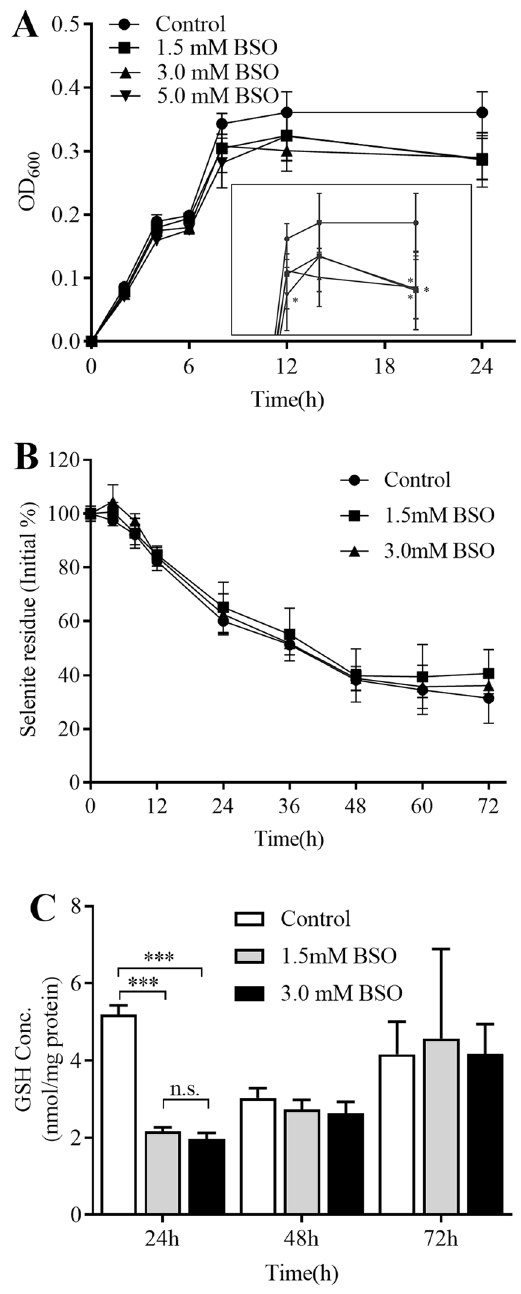
Figure 5. Effect of BSO on the growth and selenite reduction in E. cloacae Z0206 . ( A ) Growth of E. cloacae Z0206 in the presence of 1.5 mM, 3.0 mM and 5.0 mM BSO. After that, Cells were incubated in the presence of 5 mM selenite while adding 0 mM, 1.5 mM or 3.0 mM BSO. Samples were collected at different time points to determine selenite residues, and cell samples were collected at 24 h, 48 h and 72 h to measure intracellular GSH concentrations. ( B ) Selenite reduction in the presence of BSO. The result was converted to a percentage of the initial selenite concentration. ( C ) Effect of BSO on intracellular GSH concentrations. * P < 0.05, *** P < 0.001 (n =